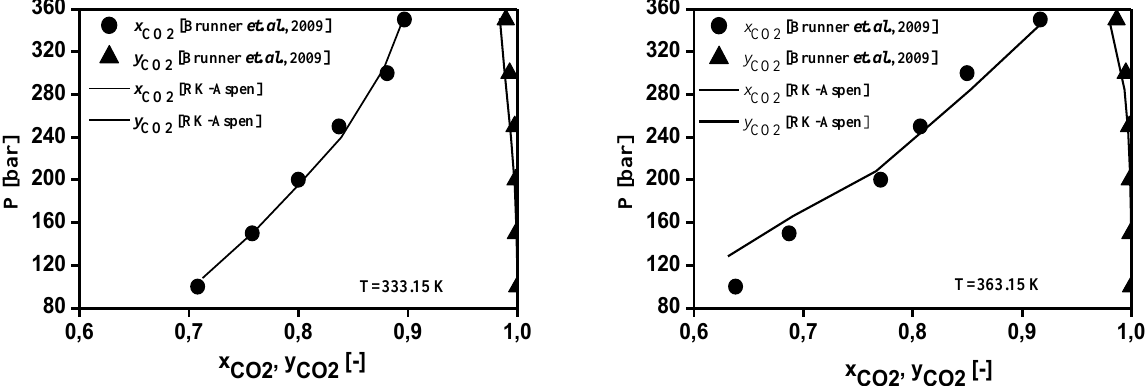
Figure 3. Experimental and predicted high-pressure phase equilibrium for the system squalene-CO 2 (Brunner et al., 2009).